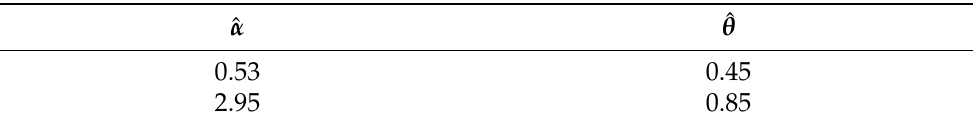
Figure 8. BTL vs. GMM from 2 to 4 components. Table 1. Estimates of BTL.